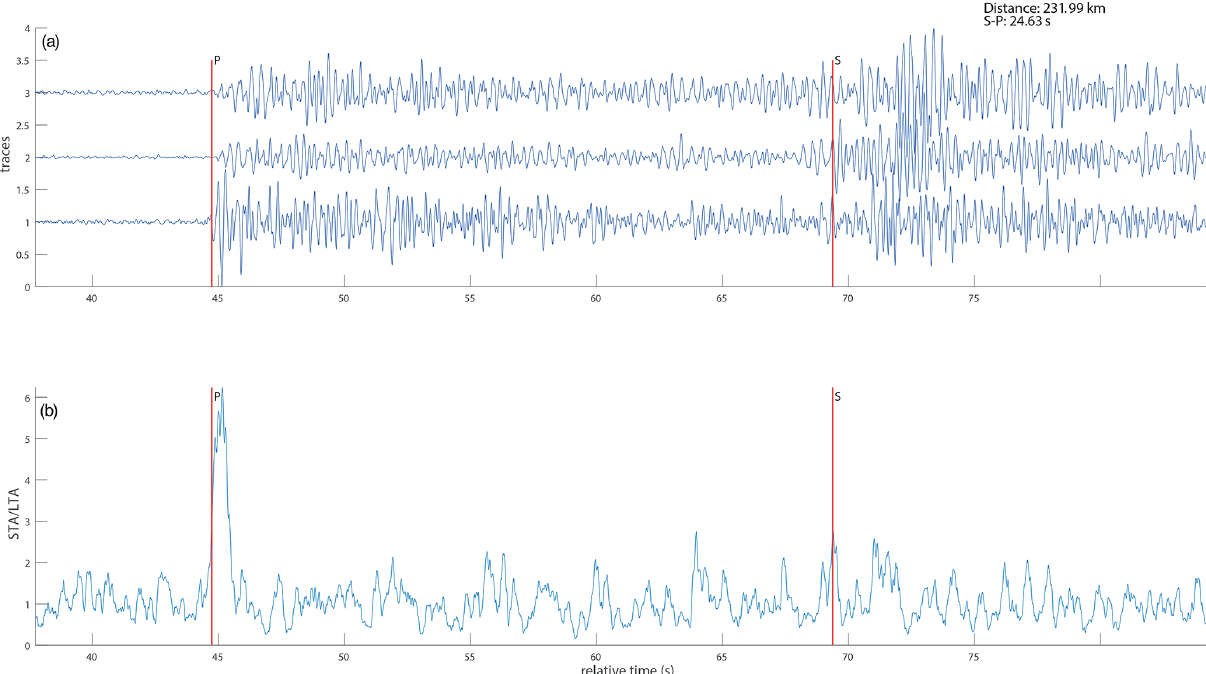
Figure 7. Estimating the epicentral distance from the arrival-time difference between S and P waves at reference station 1. The vertical, north, and east components are shown by traces 1, 2, and 3, respectively (a) . The vertical red lines show manually picked P and S phases. The picking is aided by calculating the STA / LTA of the Z component (b)